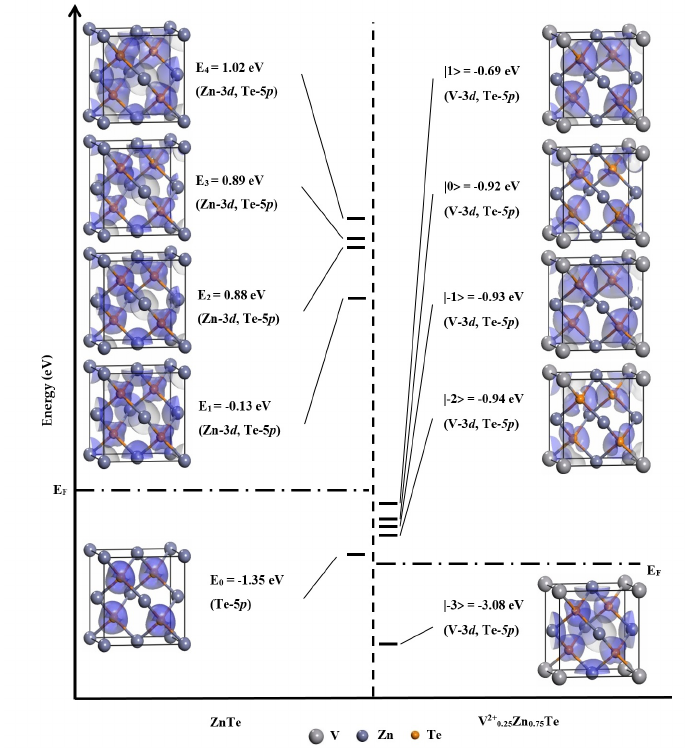
Figure 2. Left (Right) panel: HOMO and LUMO slab isosurfaces of 8-atom ZnTe (V 2 + 0.25 Zn 0.75 Te) cells arranged by energy and denoted by the shade of purple. The atoms are represented by spheres: V (gray, light), Zn (gray, dark), and Te